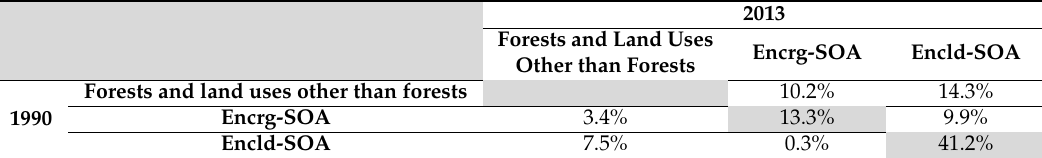
Table 3. Cross-tabulation matrix of the flows from one class to another during the 1990–2013 period, expressed in relative terms with respect to the total surface of SOA. Entries along the diagonal refer to persistence from 1990 to 2013.